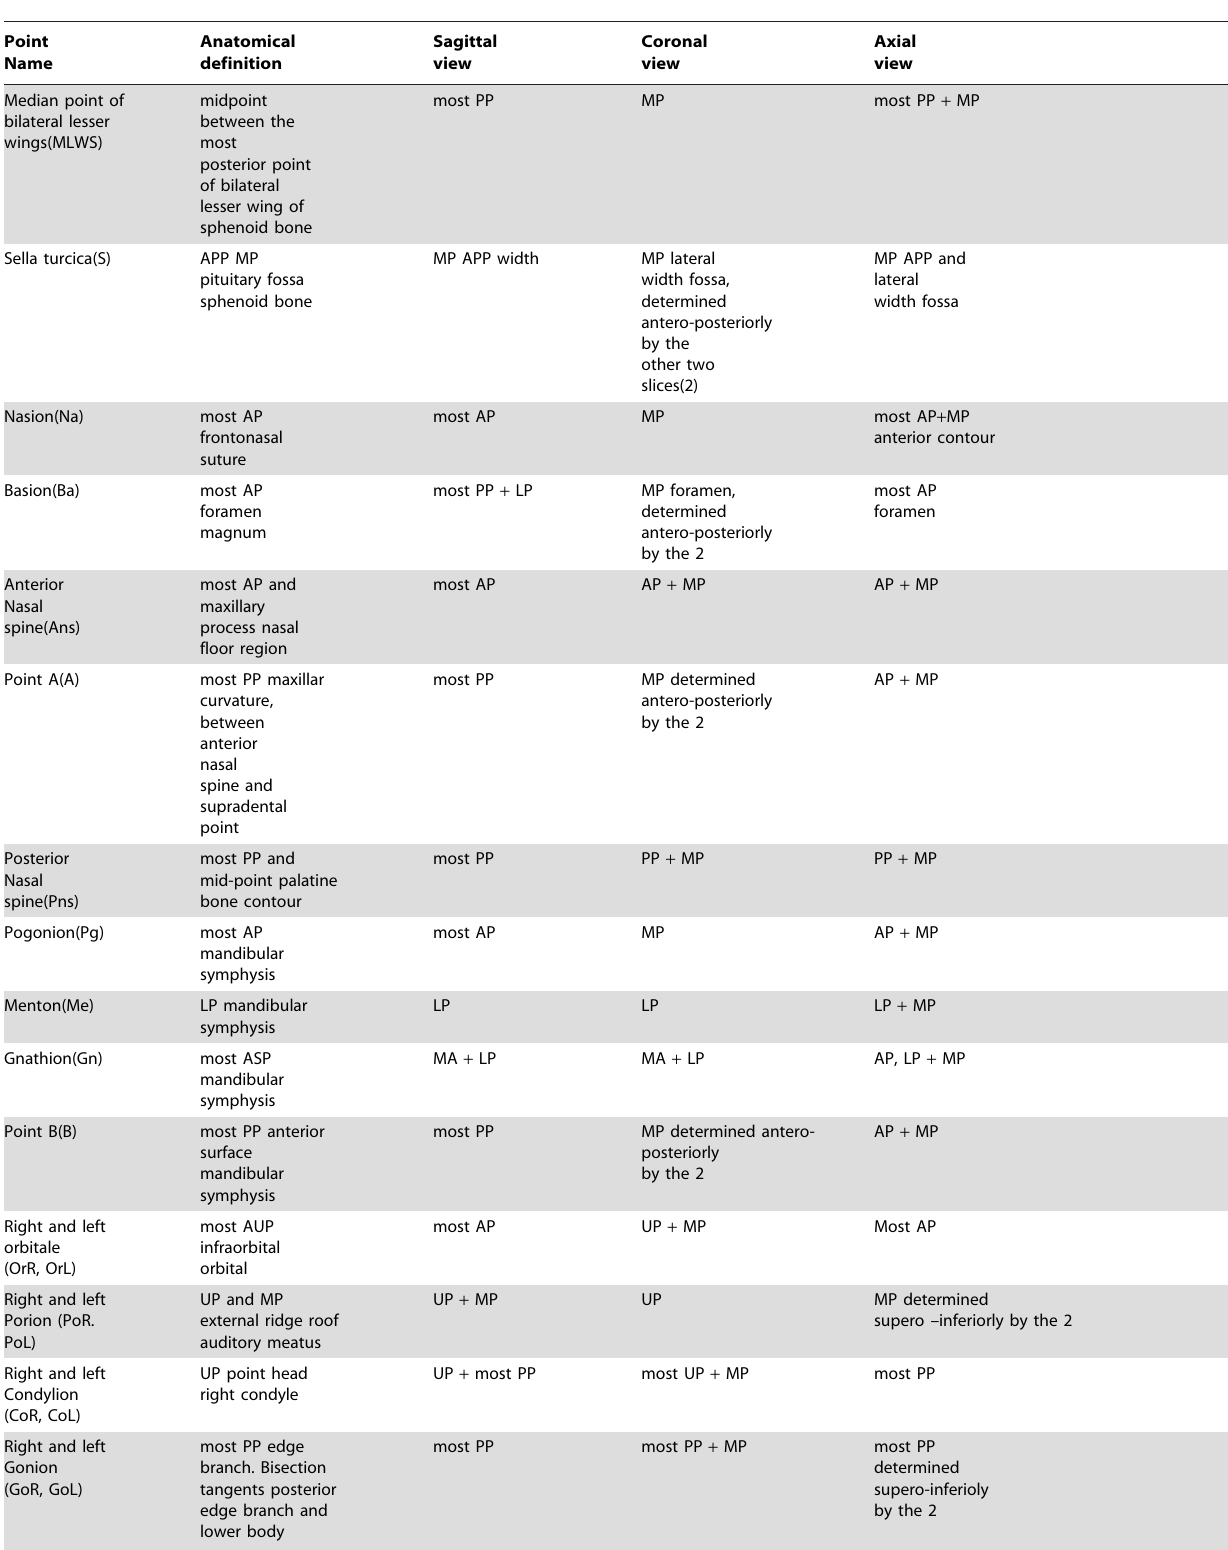
Table 1. Definition of the three spatial planes of the 19 points used in this